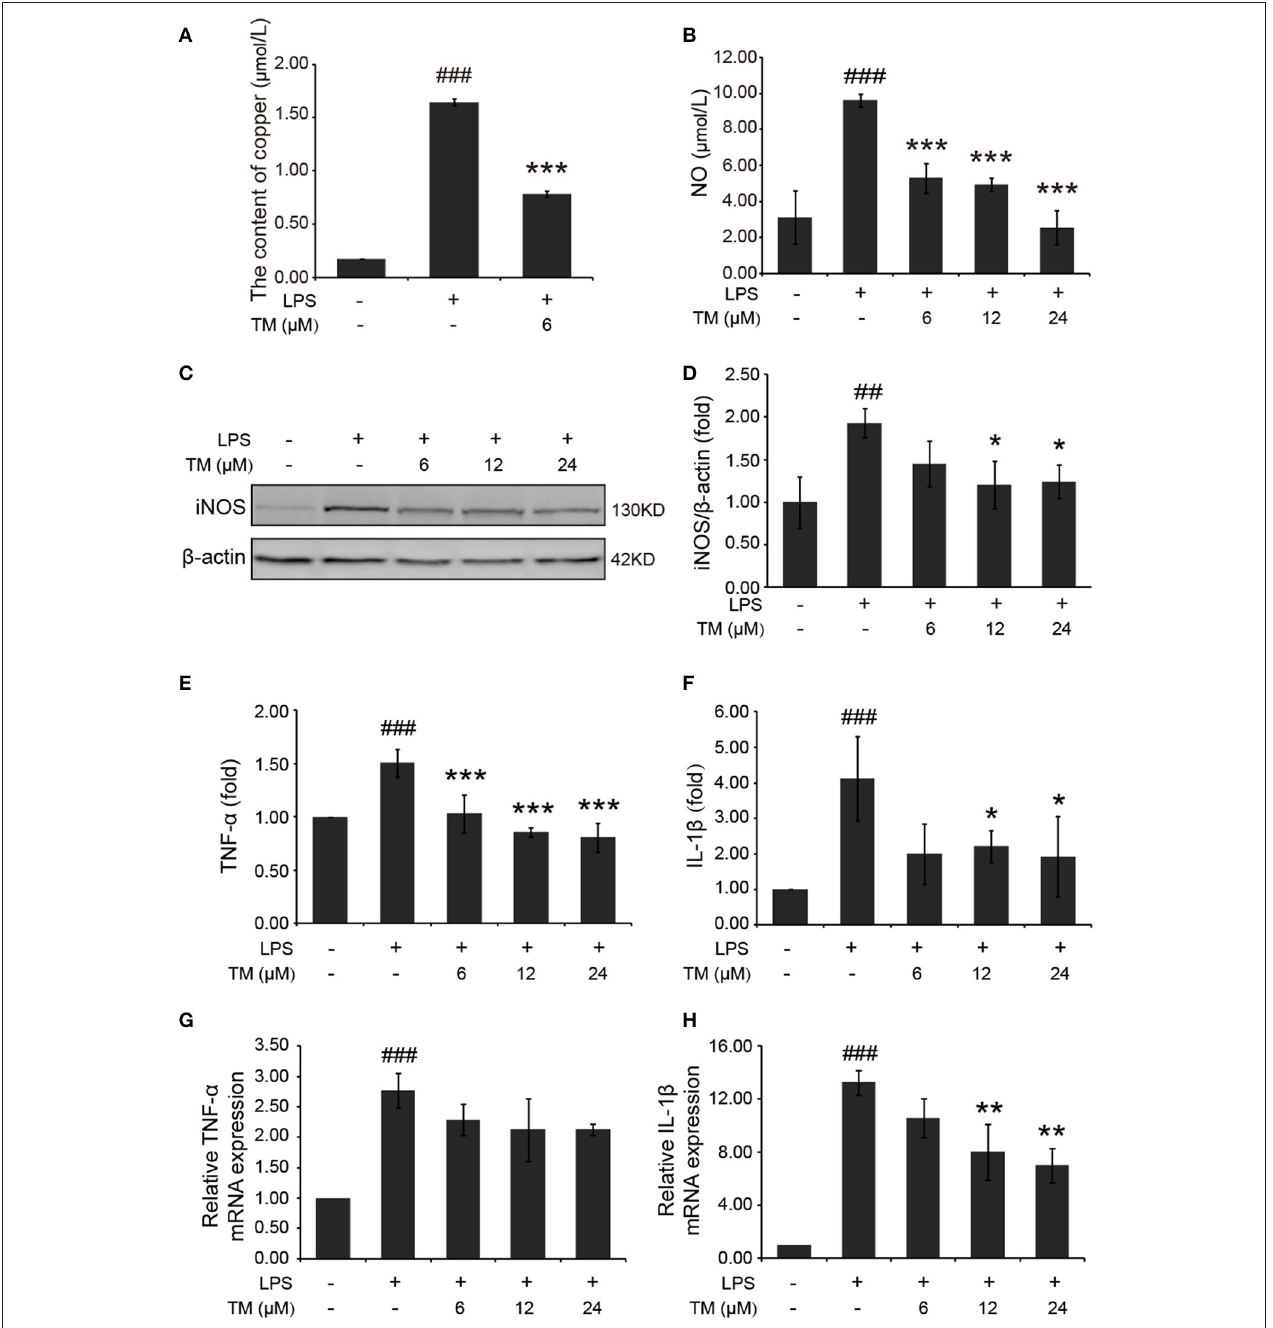
FIGURE 3 | TM-pretreatment reduces the levels of copper and inhibits the production of NO and the expression of pro-inflammatory cytokines in LPS-induced BV-2 cells. BV-2 cells were pretreated with 6, 12, 24 µ M of TM followed by treatment with 1 µ g/ml LPS for 18h. (A) The levels of copper were detected by using the ICP-MS. (B) NO production was detected by Griess agent. (C,D) Immunoblot images (C) and quantifications (D) show that TM-pretreatment suppressed iNOS expression in LPS-induced BV2 cells. (E,F) ELISA assay data show that TM-pretreatment decreased the release of TNF- α and IL-1 β in LPS-induced BV2 cells. The absolute values ranges of TNF- α and IL-1 β were 1000–2000 pg/ml and 102–993 pg/ml. (G,H) Quantitative real-time PCR (qPCR) data show that TM-pretreatment blocked TNF- α and IL-1 β mRNA expression in LPS-induced BV2 cells. Data are represented as means ± SD . of at least three independent experiments ( N ≥ 3). *** p < 0.001 ** p < 0.01, * p < 0.05 compared with the LPS; ### p < 0.001, ## p < 0.01 compared with the control. The p- values were calculated by One-way ANOVA followed by Bonferroni’s post-hoc test.